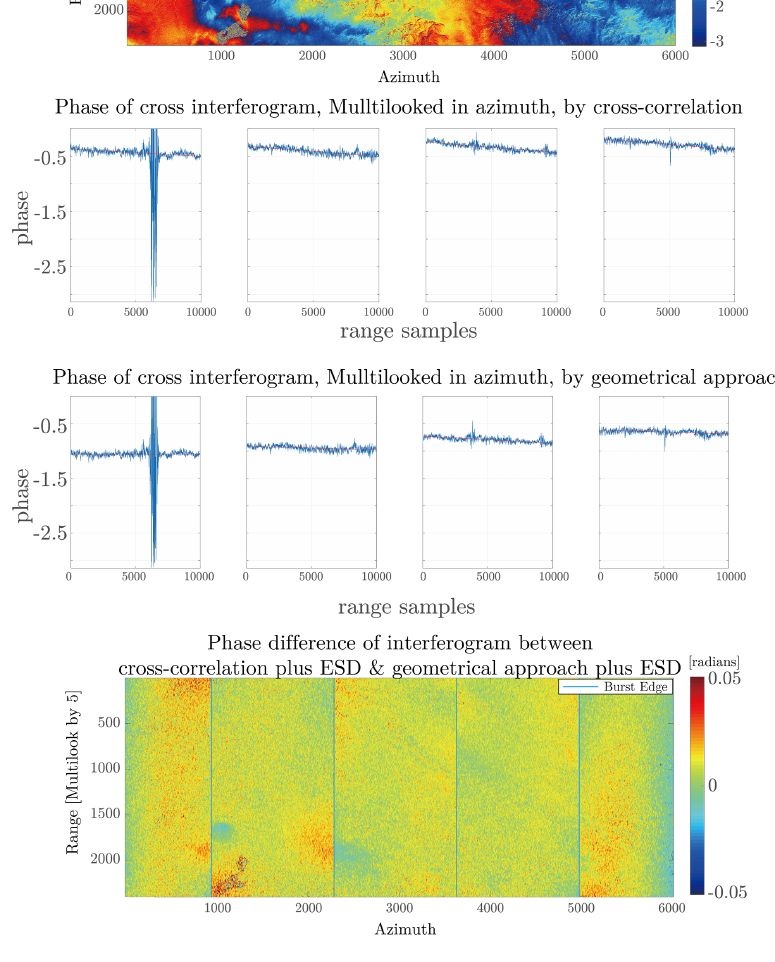
Figure 4. The Interferogram of two S1B images on 10 November 2017 and 12 November 2017 from subswath 2. ( First row ) the Interferogram, multilooked by 5 in range and no multilook in azimuth, no filter; ( Second row ) the cross-interferogram at burst overlapping area in the 1D plot after the cross-correlation method. ( Third row ) the 1-D cross-interferogram for each burst overlapping area after the geometrical approach; ( Last row ) the interferogram phase difference between the proposed approach and the established